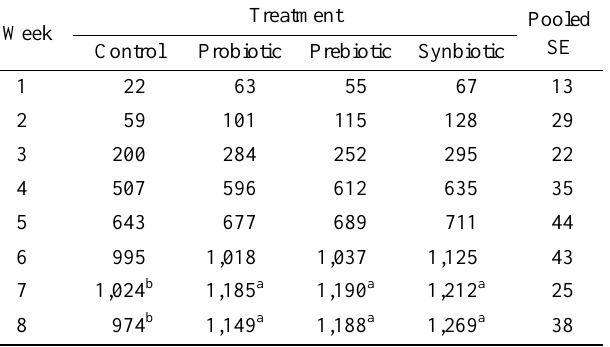
Table 4. Number of Escherichia coli (log cfu/g of wet digesta) in calves fed with or without additives Day